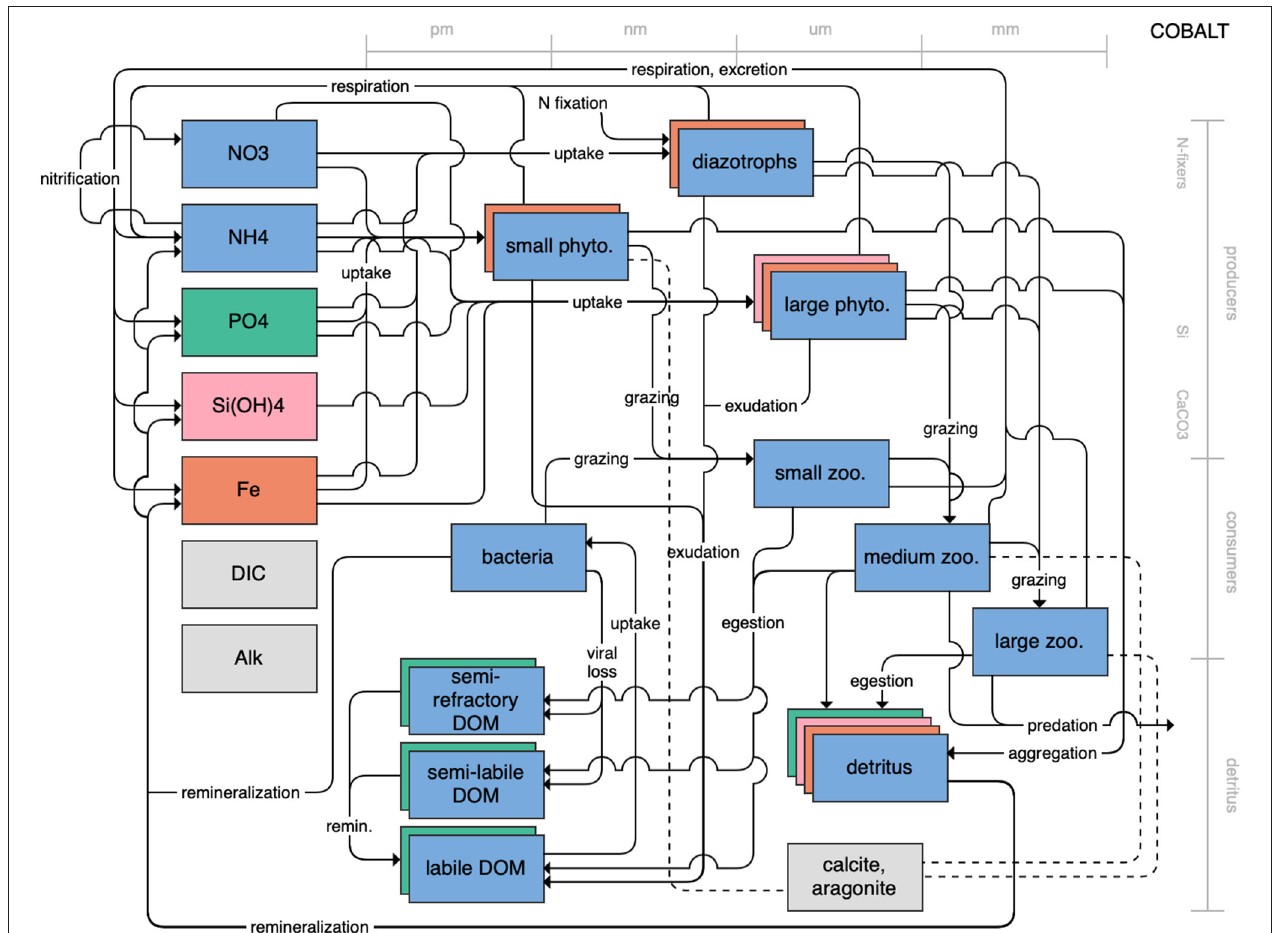
FIGURE 8 | Schematic for the COBALT model. See Figure 1 caption for